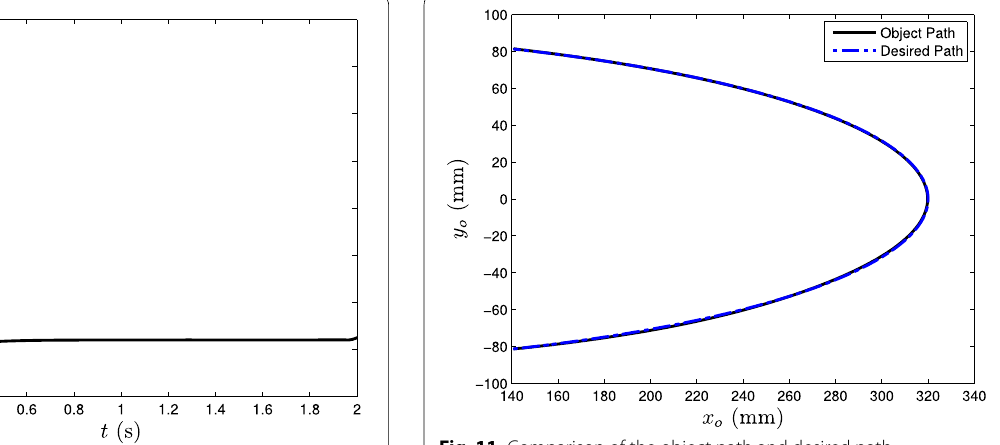
Fig. 11 Comparison of the object path and desired path